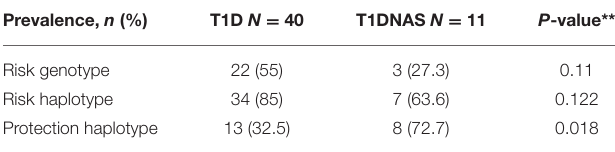
TABLE 4 | Prevalence of risk genotypes, risk haplotypes, and protection haplotypes to type 1 diabetes (T1D) in affected and non-affected siblings (T1DNAS) of type 1 diabetes multiplex families.